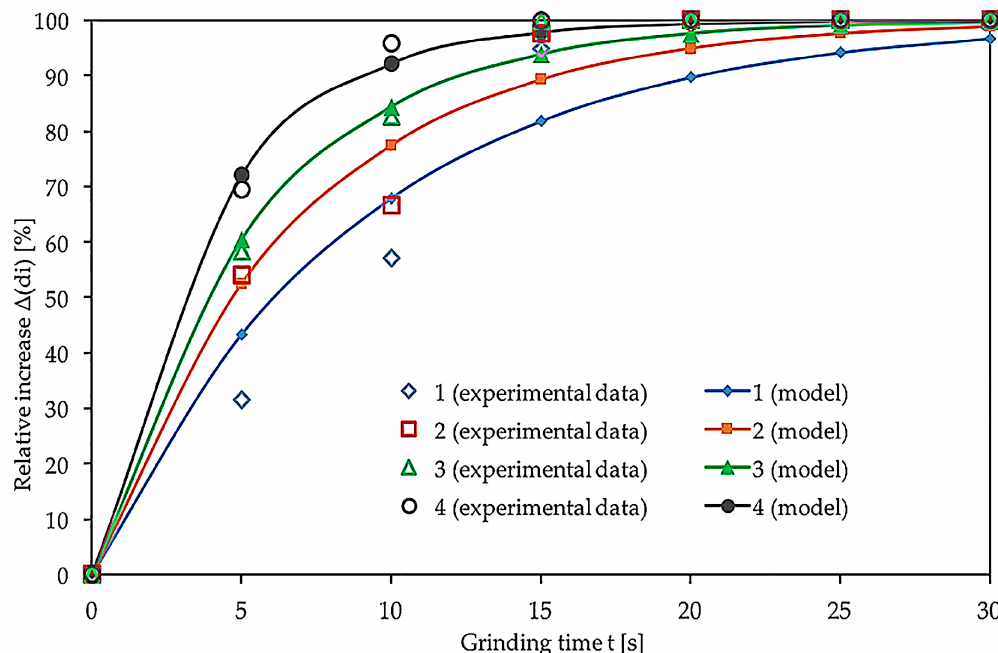
Figure 5. Curves of the relative increment of the 0–0.071 mm particle size fraction in the comminution product for the investigated grinding media characteristics.